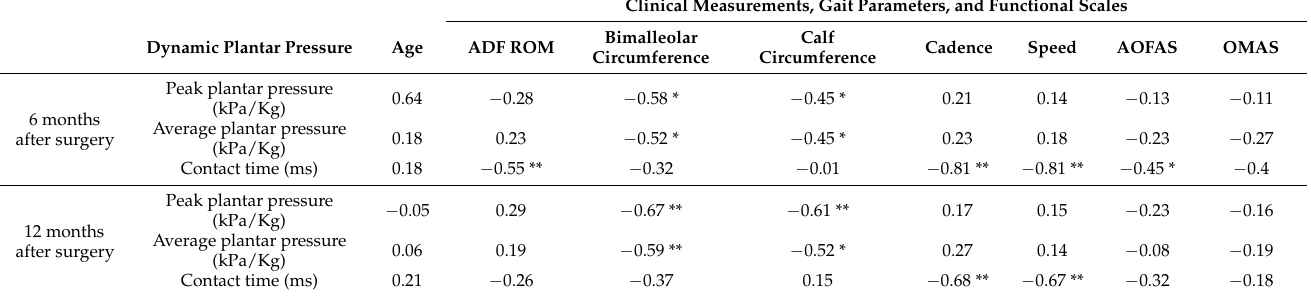
Table 7. Correlation between clinical measurements, gait parameters, and functional scales with dynamic plantar pressure in operated ankle at 6 and 12 months after